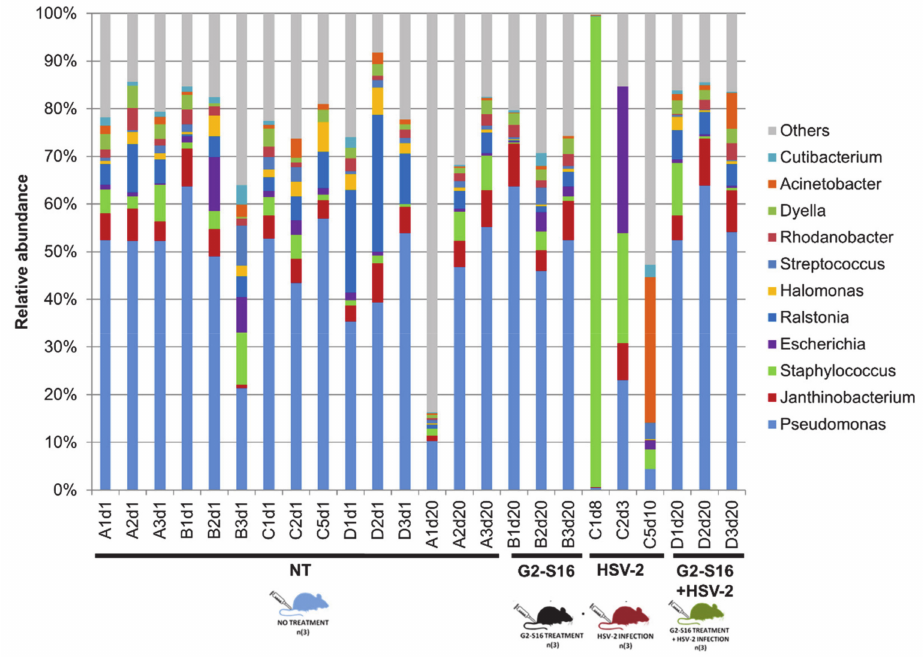
Figure 5. Comparison of vaginal microbiomes at the genus level. Relative abundances comparing the reads to nucleotide (nt) database (NCBI). Samples are clustered in groups NT, G2-S16, HSV-2, and G2-S16 + HSV-2. Group NT consisted of control mice without any treatment. Group G2-S16 consisted of mice treated vaginally with 1% HEC gel and G2-S16 dendrimer as an active ingredient. Group HSV-2 consisted of mice HSV-2 infected, and group G2-S16 + HSV-2 consisted of mice treated with 1% HEC gel with G2-S16 and infected with HSV-2. Coding color and nomenclature of samples analyzed by metagenomics are those used in Figures 2 and 3: capital letter “A–D” refers to the type of samples (A = healthy untreated or NT; B = treated with dendrimer or G2-S16; C = infected with HSV-2; D = treated with dendrimer and post-infected with HSV-2), number “n” refers to replicate samples, and “d-number” refers to sacrificed day.